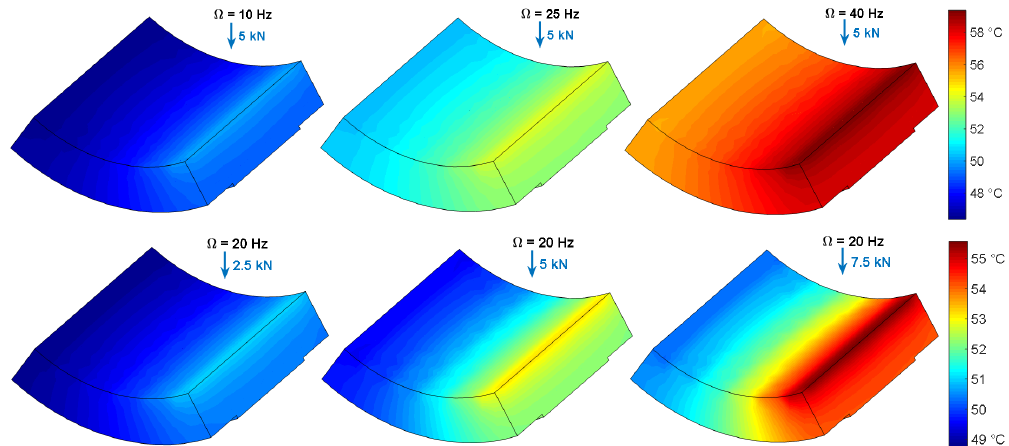
Figure 19. Predicted temperature distribution on pad #1 as a function of shaft speed ( upper ) and applied static load ( lower ) in the test bearing.